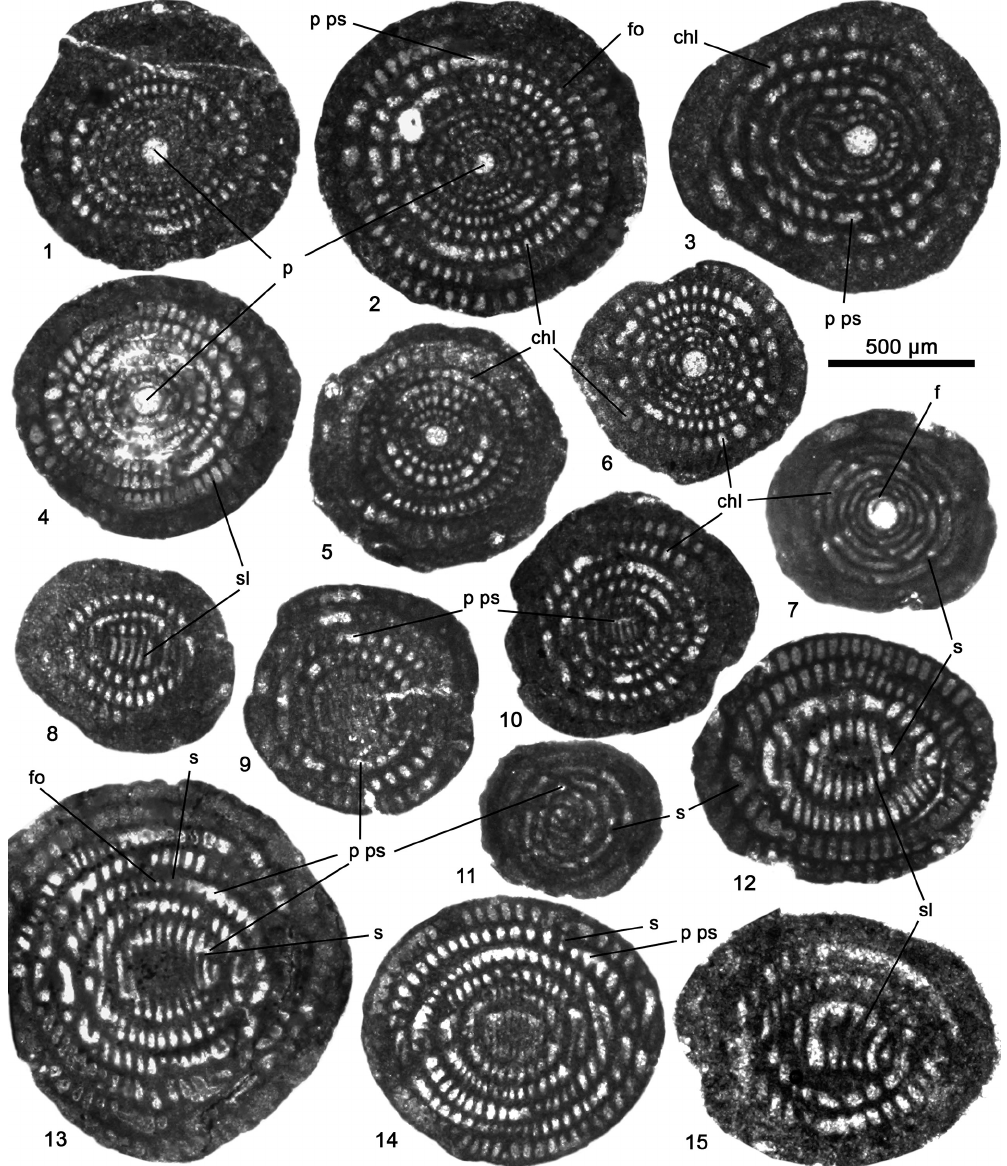
Figure 7. Simplalveolina mardinensis n. sp. from the middle Cenomanian, Derdere Formation at Derik, Mardin, south-eastern Turkey. Transmitted light photographs of thin sections of cemented carbonate rocks. Specimens cut off from surrounding matrix: (1, 2, 4) Sample DRK29, (3, 5, 9, 15) Sample DRK9, (6, 8, 10) Sample DRK23, (7, 11, 14) Sample DRK22, and (12, 13) Sample DRK24. Plate (1) is the holotype, and Plates (2) – (15) are paratypes. Architectural element abbreviations used in this figure and Fig. 8 are as follows: c chl, cortical chamberlet; chl, chamberlet; f, flexostyle; fo, foramina; m chl, medullar chamberlet; p, proloculus; p ps, preseptal passage; s, septum; sl, septulum; sp chl, supplementary chamberlet. See the glossary of Hottinger (2006) and Vicedo (2009) for the definition of